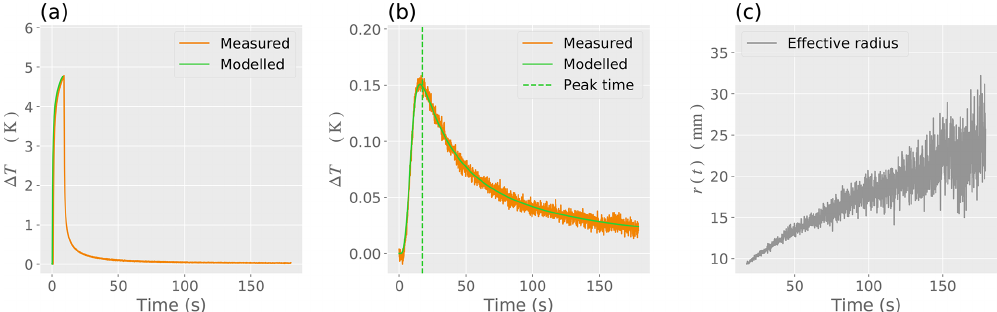
Figure 5. Example signal processing for sand showing (a) the measured and modelled SP heating curves; (b) the measured and modelled DP heating curves along with the detected peak time; (c) the detected change in effective radius r(t) from the signal processing. The effective radius r(t) as obtained from signal processing compensates for model error, experimental error, and physical changes in the spacing of the heater needles. Table 4. Comparisons for sand example. Quantity and units Signal processing Heating